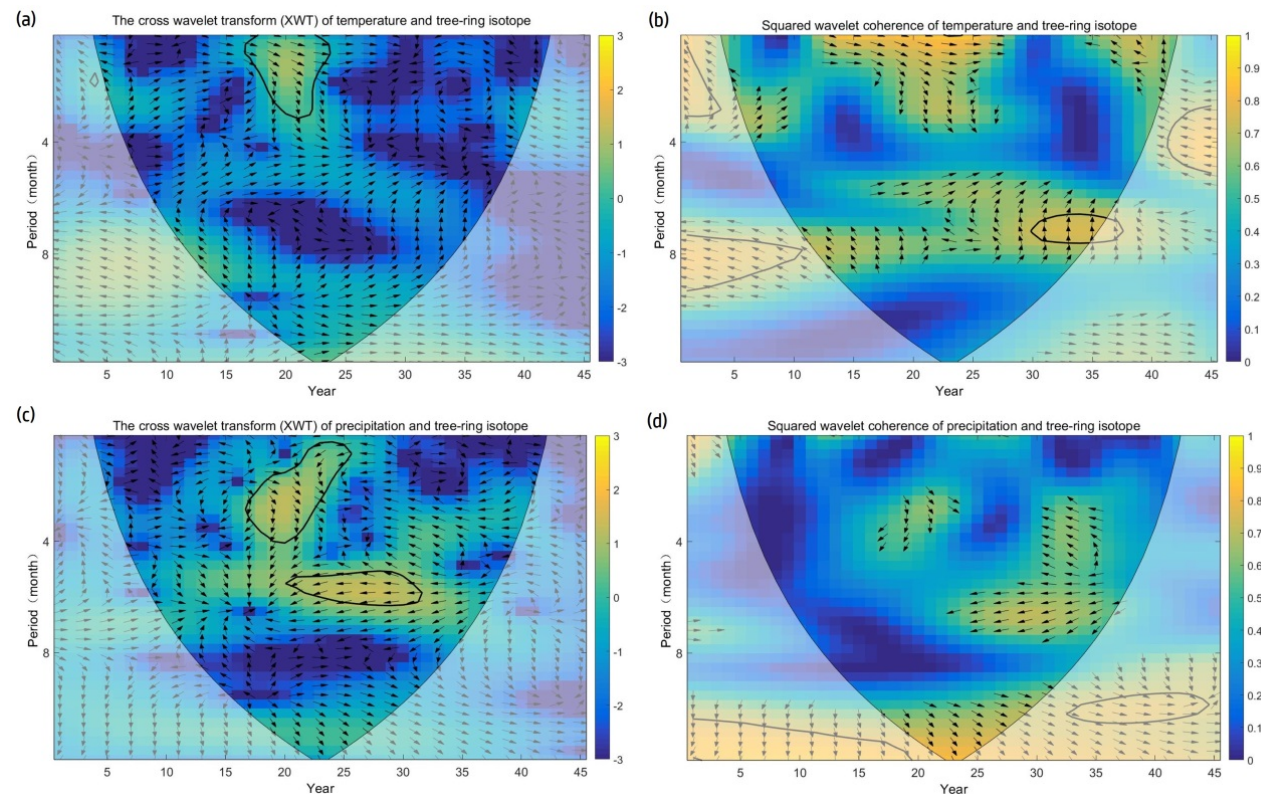
Figure 6. ( a ) Cross-wavelet transform of the temperature and tree-ring isotopes; ( b ) wavelet coherence between temperature and tree-ring isotopes; ( c ) cross-wavelet transformation of the precipitation and tree-ring isotopes; ( d ) wavelet coherence between precipitation and tree-ring isotopes. The 5% significance level against the yellow noise is shown as a thick contour. The relative phase relationship is shown as arrows (with in-phase pointing right and antiphase pointing left). Arrows indicate the phase of the coherence, where the right is in-phase and the left is antiphase. Table 4. Cross-correlation between ∆ 13 C chronology and climatic factors (temperature and precipitation) and lags between them.